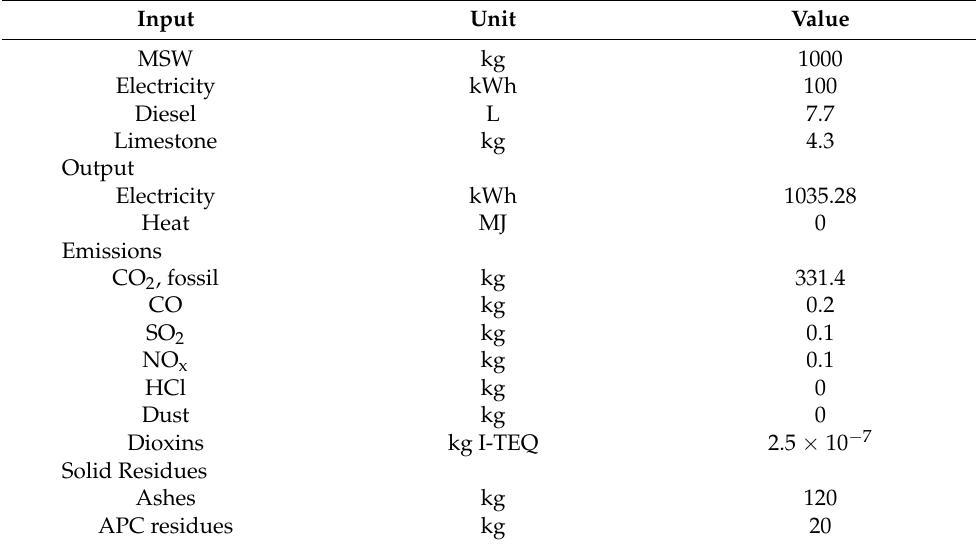
Input/output based on theoretical analysis and secondary data derived from Dong et al. [65] & Tang et al.